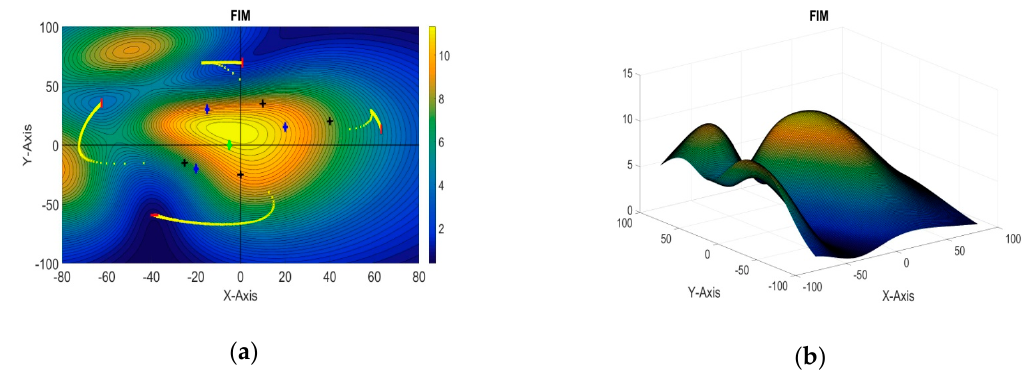
Figure 7. ( a ) 2D contour plot of the evaluation function (4 + 1 sensors, three targets); ( b ) 3D plot of the evaluation function (4 + 1 sensors, three targets).